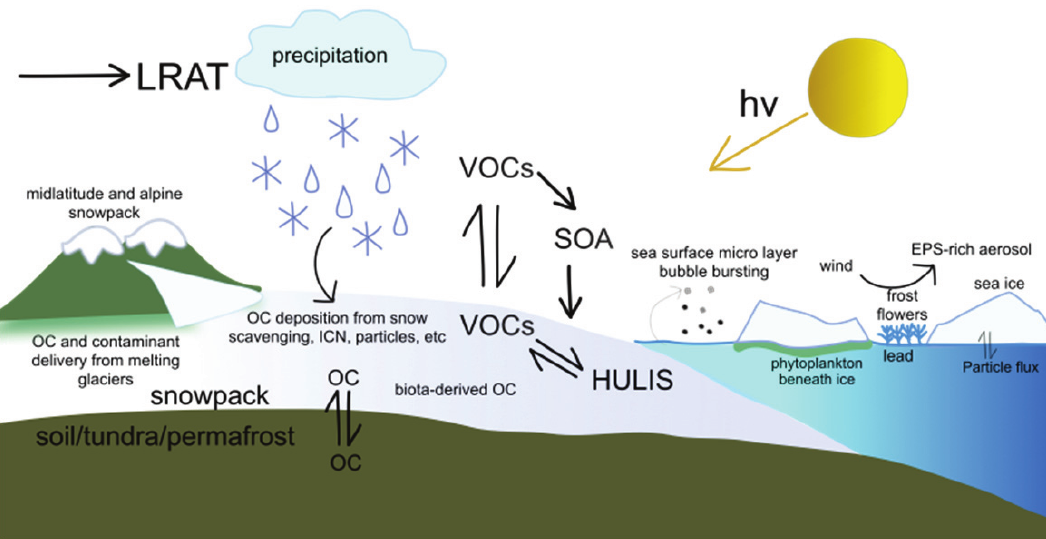
Fig. 1. Biogeochemical cycle of organic carbon in the cryosphere. LRAT: long range atmospheric transport. VOC: volatile organic compound. SOA: secondary organic aerosol. HULIS: humic-like substances. EPS: exopolymeric